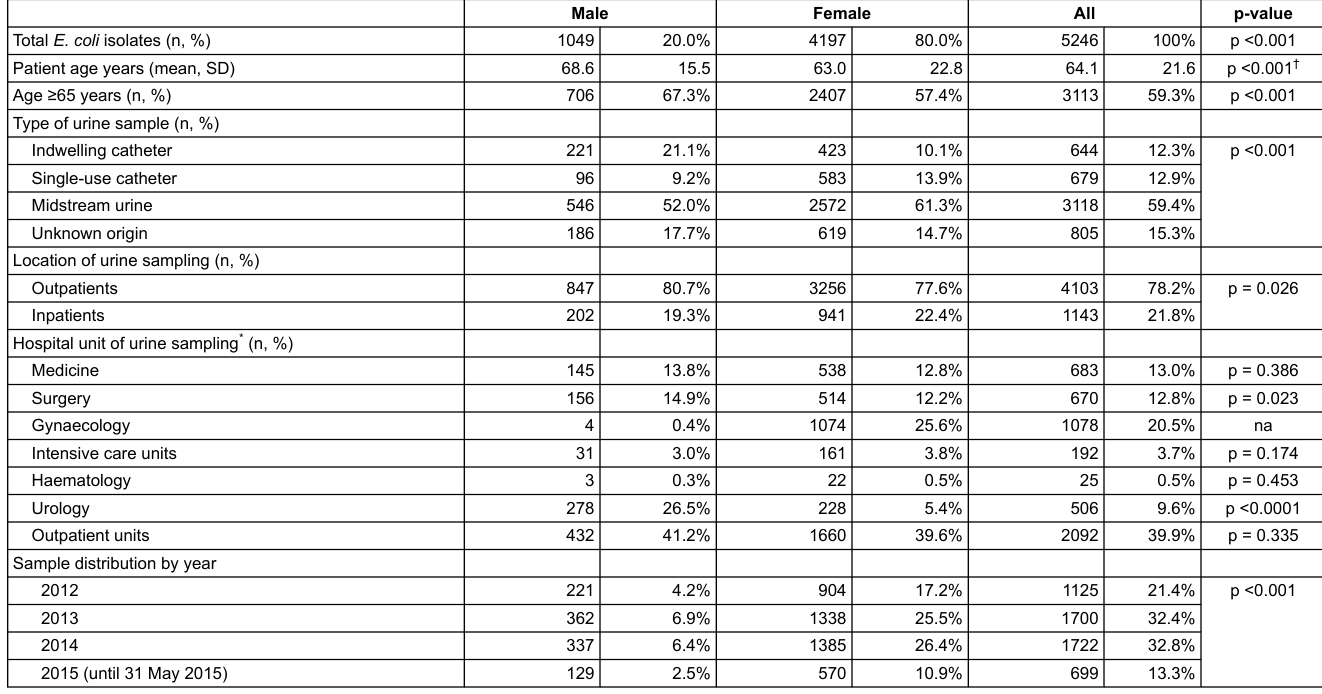
Table 1: Baseline characteristics of all E. coli urine samples with available atimicrobial susceptibility testing resuots (n =